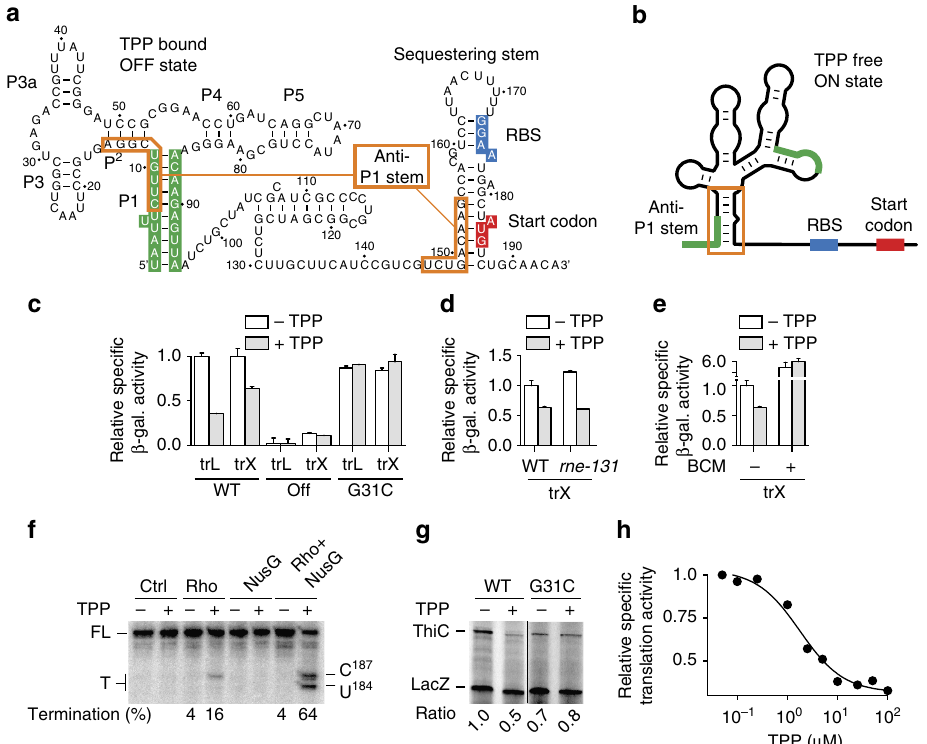
Figure 1 | The thiC riboswitch controls gene expression at the levels of transcription and translation. ( a ) Secondary structure of the thiC riboswitch representing the TPP-bound state. The P1 stem, the RBS and the start codon are represented in green, blue and red, respectively. The anti-P1 stem is shown in orange rectangles. The nomenclature of the helical domains is based on a previous study 12 . ( b ) Schematic representing the TPP-free state determined in this study. The colour scheme is the same as in a . ( c ) b -Galactosidase assays of translational ThiC–lacZ (trL) and transcriptional thiC–lacZ (trX) fusions for the wild type, ON, OFF and G31C mutants. Values were normalized to the activity obtained for the wild type in the absence of TPP. The average values of three independent experiments with s.d.’s are shown. ( d ) b -Galactosidase assays of transcriptional thiC-lacZ (trX) performed in the context of the wild-type and rne-131 strains. Values were normalized to the activity obtained for the wild type in absence of TPP. The average values of three independent experiments with s.d.’s are shown. ( e ) b -Galactosidase assays of transcriptional thiC–lacZ (trX) performed in the wild type in absence or presence of TPP or bicyclomycin (BCM). Values were normalized to the activity obtained for the wild type in absence of TPP. The average values of three independent experiments with s.d.’s are shown. ( f ) In vitro Rho-dependent transcription performed using the thiC riboswitch. Full-length (FL) and termination (T) products are indicated on the left. Termination efficiencies are indicated below for reactions done with Rho. Termination products are indicated on the right. ( g ) Transcription–translation-coupled in vitro assays using the wild type and G31C mutant. Reactions were performed in absence ( (cid:2) ) or presence ( þ ) of TPP. Translation products are shown on the left and ratios of ThiC expression are normalized to that of LacZ. ( h ) Transcription–translation-coupled in vitro assays using the wild-type riboswitch. The half transition of translation repression corresponds to a value of 1.7 ± 0.3 m M. NATURE COMMUNICATIONS|8:13892|DOI: